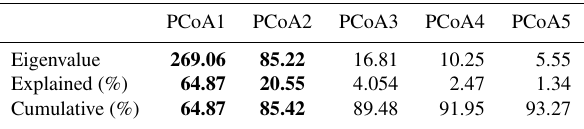
Table 1. Results of the principal coordinates analysis (PCoA). Sig- nificant axes, as determined by the broken stick method (Bennett, 1996), are shown in